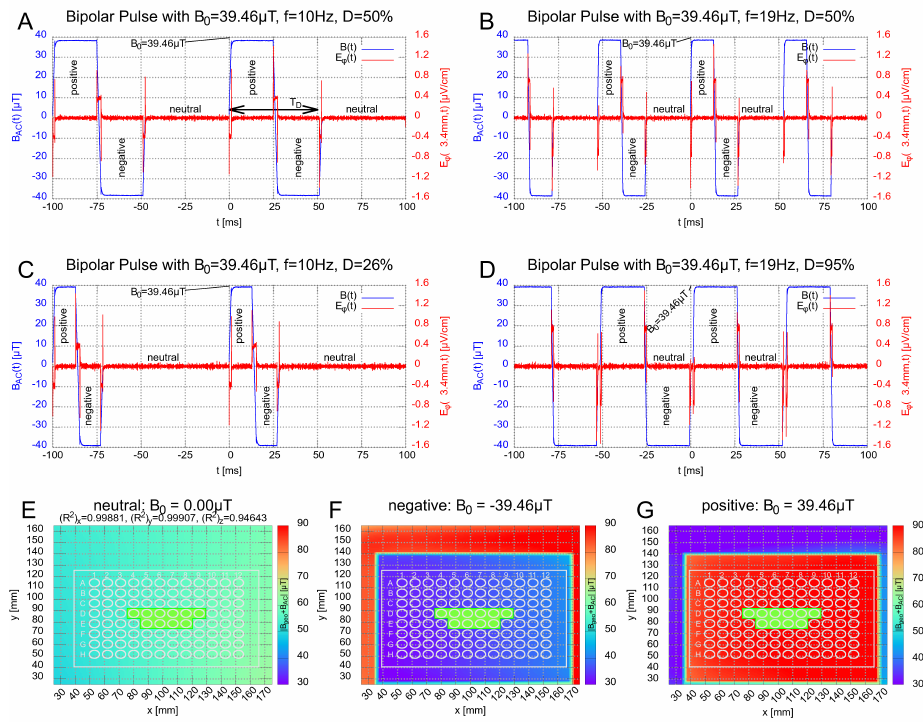
Figure 2. Subfigures ( A – D ): Show the signal shape of the magnetic field (blue) for the bipolar rectangular pulses with 10Hz and 19Hz, respectively. The altered magnetic-field duration T D (defined in subfigure ( A )) was chosen to be T D = 26.32ms and T D = 50ms. Each bipolar signal has three states, labeled with positive , negative and neutral . The duty cycles of the signal in ( C , D ) were chosen to reflect a T D equivalent to the signal in ( A , B ), respectively. The red curve represents the Φ - component of the induced electric field E Φ , which was calculated by the induction law (Supplement, Section S3.3) and stays below ≤ 1.6 × 10 − 6 V for all fields at well boundary at R = 3.4 mm ( 6.8 m (cid:31)